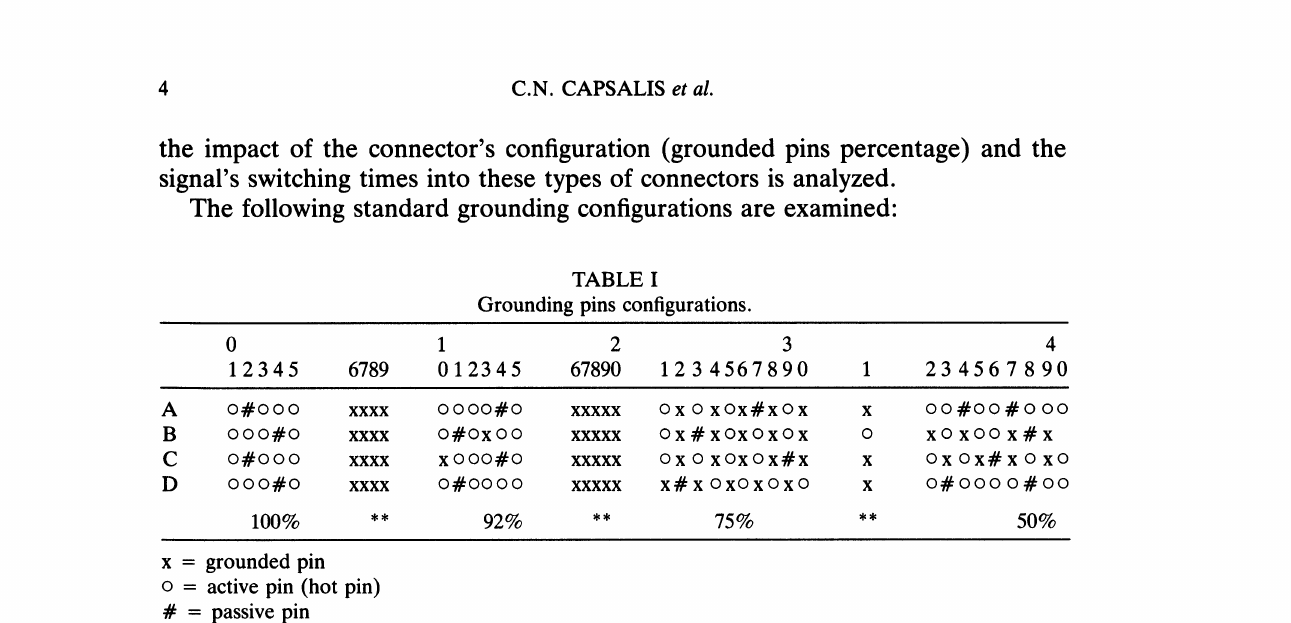
Grounding pins configurations.